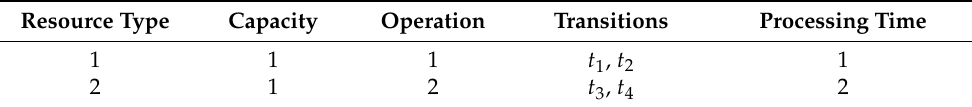
Table 3. Data for Operations, Transitions and Resources involved in Type-1 Tasks. Resource Type